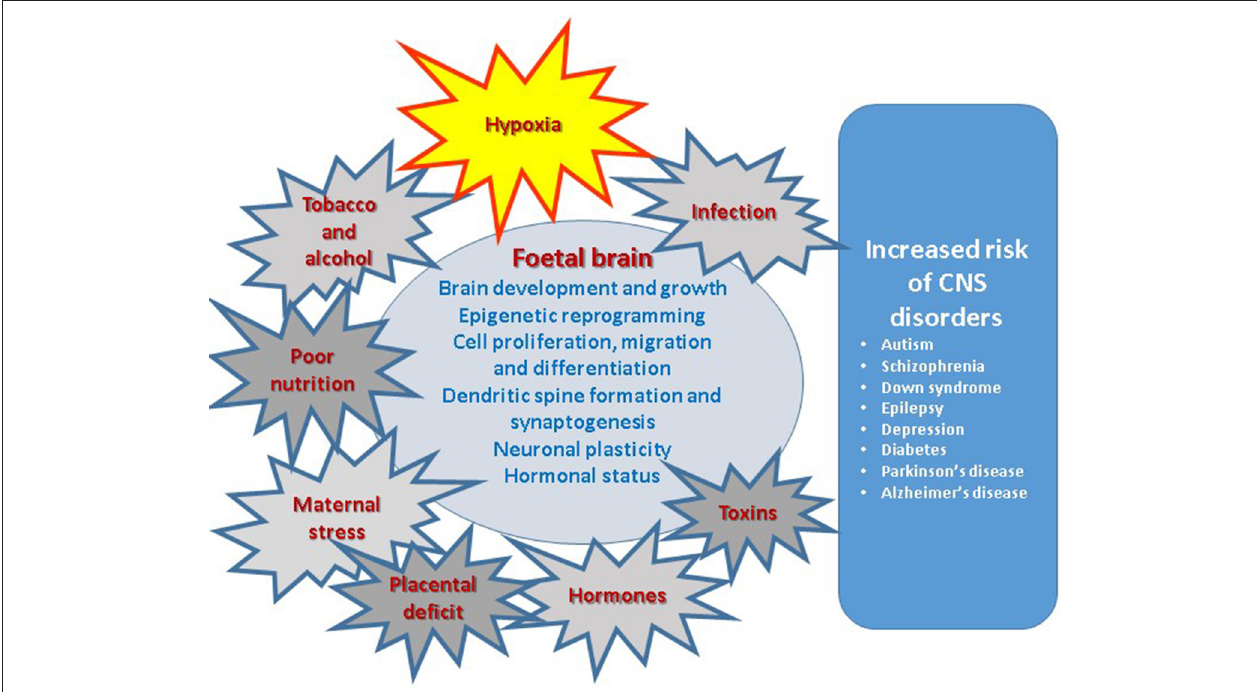
FIGURE 1 | Prenatal factors affecting various aspects of brain development result in increased risk of central nervous system disorders in postnatal life.